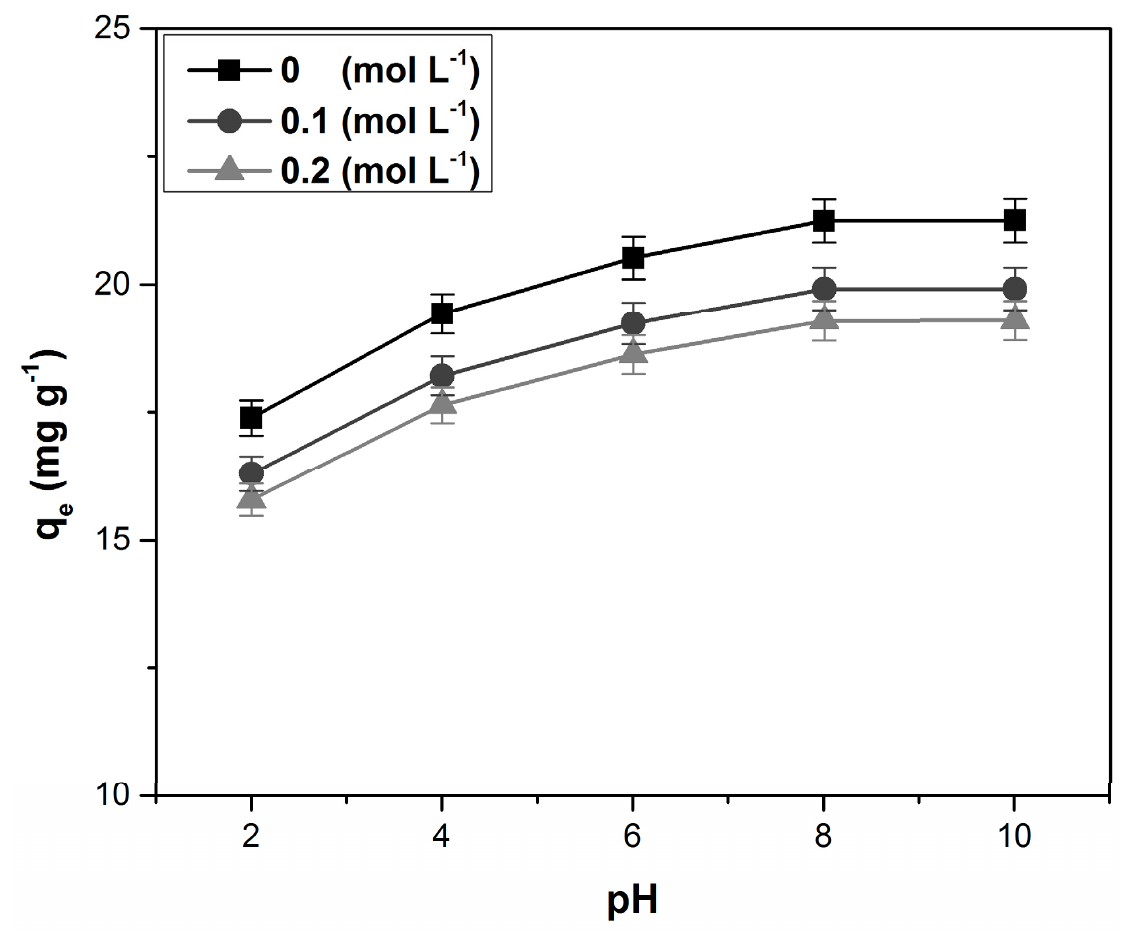
Figure 5. The dependence of adsorption capacity with the dye solution pH, at different ionic strengths.